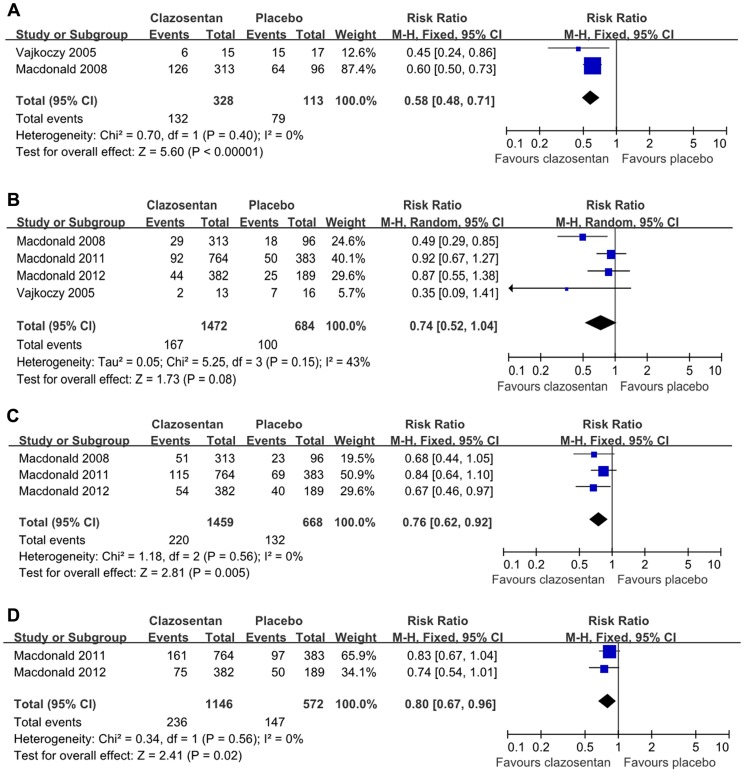
Effects of clazosentan in the prevention of angiographic vasospasm, vasospasm-related NCI, DIND, and vasospasm-related M/M.(A) Forest plot of RR and 95% CI for the incidence of angiographic vasospasm in patients assigned to clazosentan treatment versus placebo. (B) Forest plot of RR and 95% CI for the incidence ofvasospasm-related NCI in patients assigned to clazosentan treatment versus placebo. (C) Forest plot of RR and 95% CI for the incidence of vasospasm-related DIND in patients assigned to clazosentan treatment versus placebo. (D) Forest plot of RR and 95% CI for the incidence of vasospasm-related M/M in patients assigned to clazosentan treatment versus placebo.